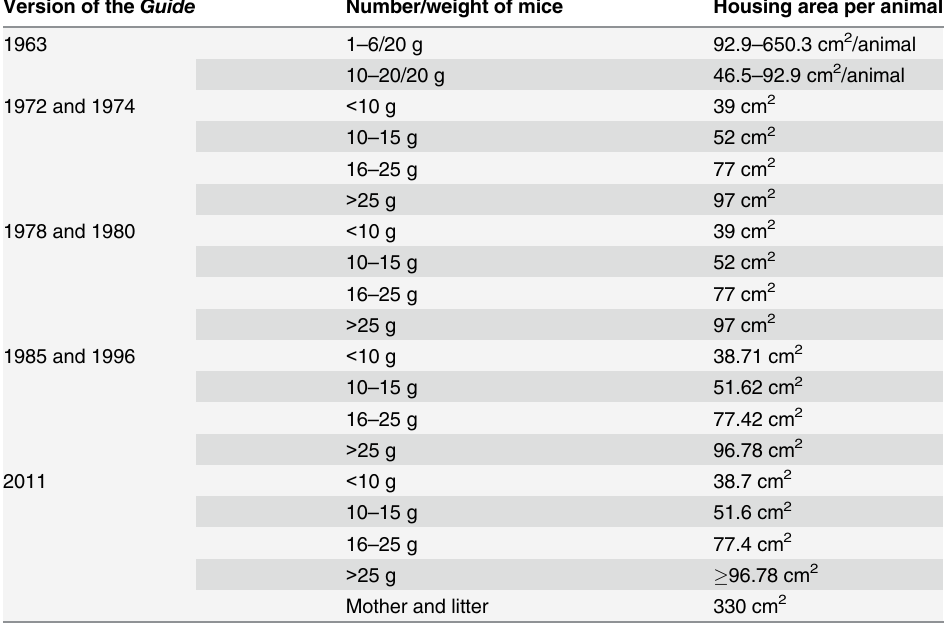
Table 1. Evolution of cage space requirements for mice through versions of the Guide